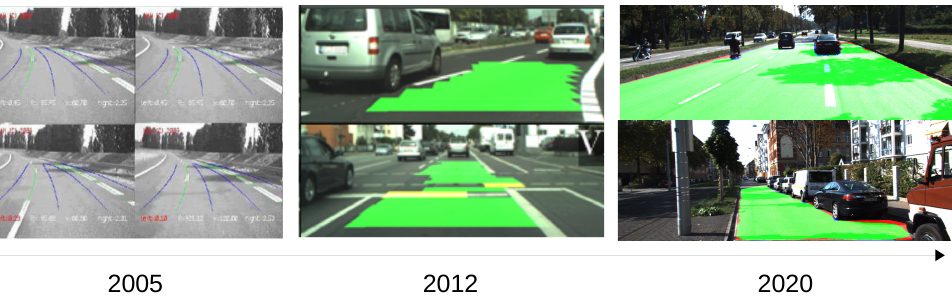
Figure 2. Evolution of road/lane segmentation for intelligent vehicles with three examples from